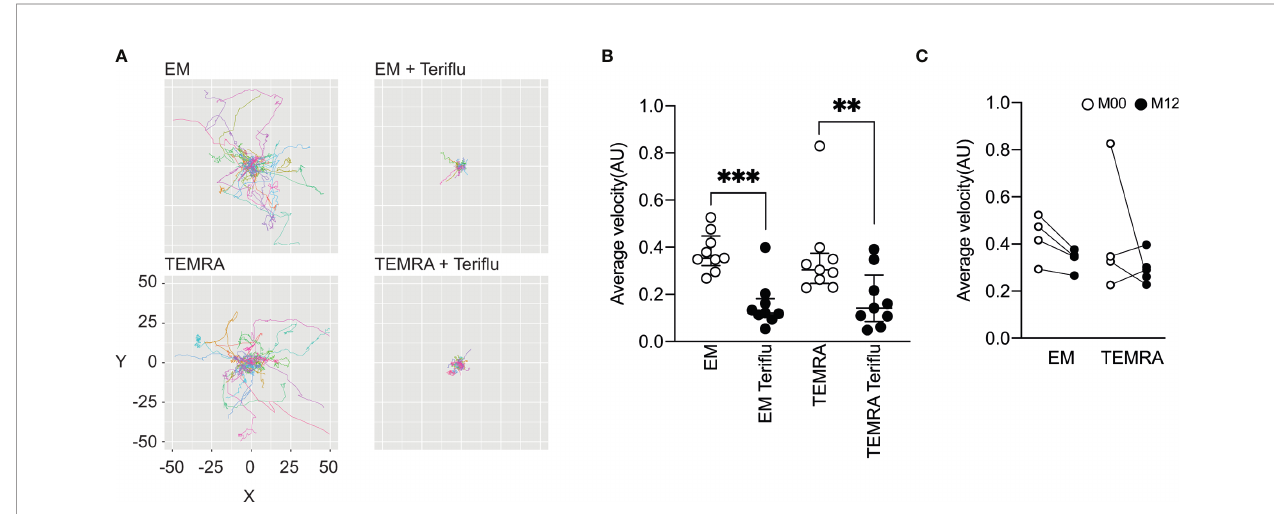
FIGURE 3 | Teri fl unomide inhibits the migration of EM and TEMRA CD8 T cells in patients with RRMS. (A, B) Migration of Fura-2-labeled CD8 T cell subsets of patients with RRMS onto TNF a (100 U/ml, O/N)-treated HDMEC monolayers and, as indicated, when teri fl unomide (100 µM) was added 15 ’ after the initial recording. Paths of individual cells were aligned to their origins at x=y=0 (A) , and the average velocity (B) of CD8 T cell subsets is shown. (C) Migration of Fura-2- labeled CD8 T cell subsets of patients with RRMS at M00 (white) and at M12 (black) post-teri fl unomide treatment onto TNF a (100 U/ml, O/N)-treated HDMEC monolayers. Average velocity of CD8 T cell subsets is shown. (B, C) Each dot represents a unique patient, and the median and interquartile ranges (IQRs) are shown. Signi fi cance was determined by unpaired Mann-Whitney U test (**p < 0.01; ***p <